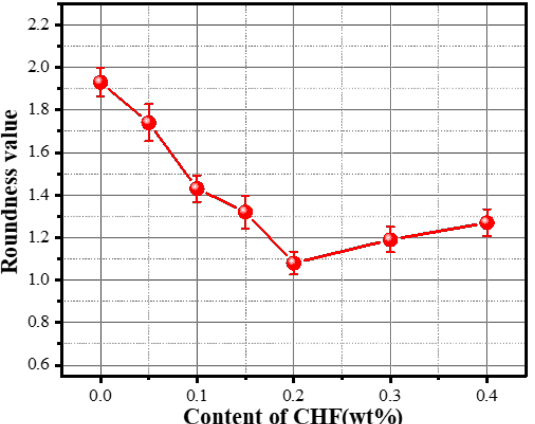
Figure 10. Influence of the content of CHF on the roundness value of the material.